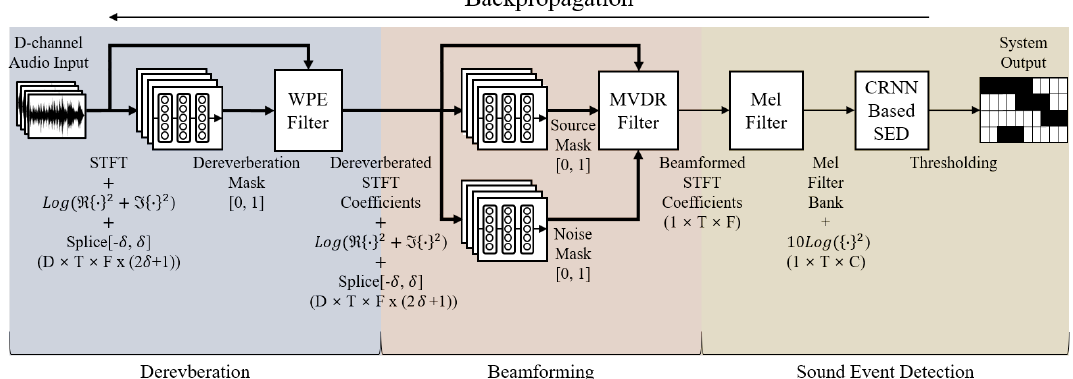
Figure 1. Block diagram of the proposed system. WPE, weighted prediction error; MVDR, minimum variance distortionless response; SED, sound event